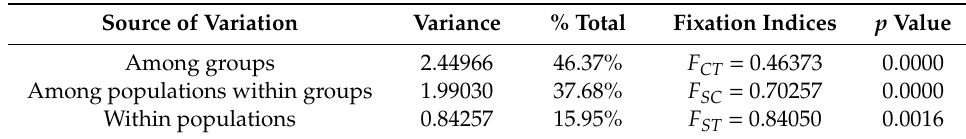
Figure 4. Scatter plot of Nei’s genetic distance vs. geographical distance (based on longitude and latitude coordinates) for P. glacialis populations (Mantel test). Table 3. Analysis of molecular variance (AMOVA) for populations of P. glacialis based on data from four mtDNA fragments.